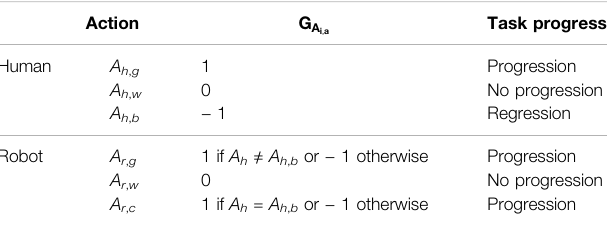
(cid:2) 1), making no progression ( G i , a (cid:2) − i , a